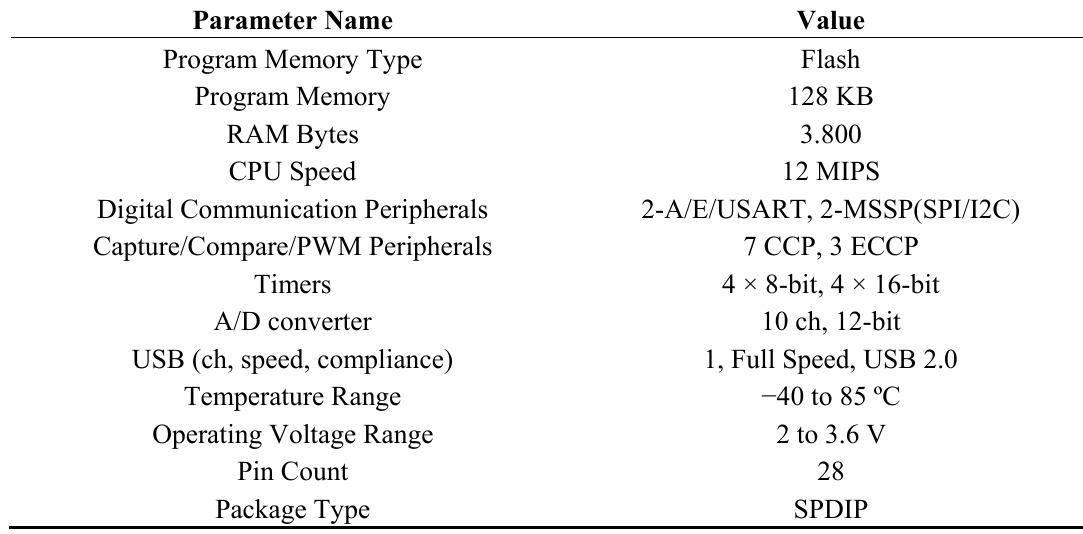
Table 2. Microchip PIC18F27J53